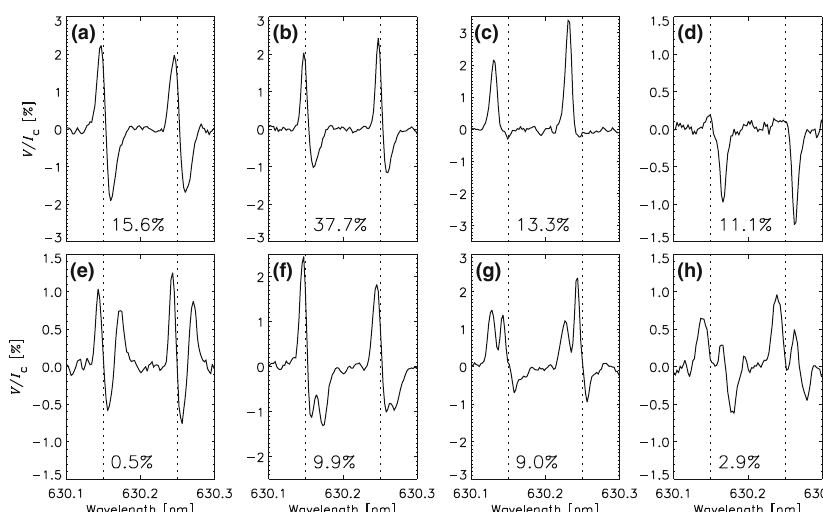
Fig.24 Classification of Fe i 630.15 and 630.25 nm Stokes V profiles observed by Hinode in a quiet Sun IN region at disk center with a resolution of 0 . 3 (cid:2)(cid:2) . The dotted lines indicate the central wavelengths of the two lines. The profiles exhibit distinct spectral signatures. Panel a displays a prototypical regular profile with two lobes of opposite sign. The other panels show profiles with increasingly larger asymmetries ( b ), only one lobe ( c and d ), three lobes ( e ), bumps in the one of the lobes ( f and g ), and even four lobes ( h ). The causeofthesespectralfeaturescanbetracedbacktothephysicalprocessesatworkonthesolarsurface.The numbers shown in each panel give the fraction of IN profiles belonging to the different classes, considering only those pixels with signals above 6 times the noise